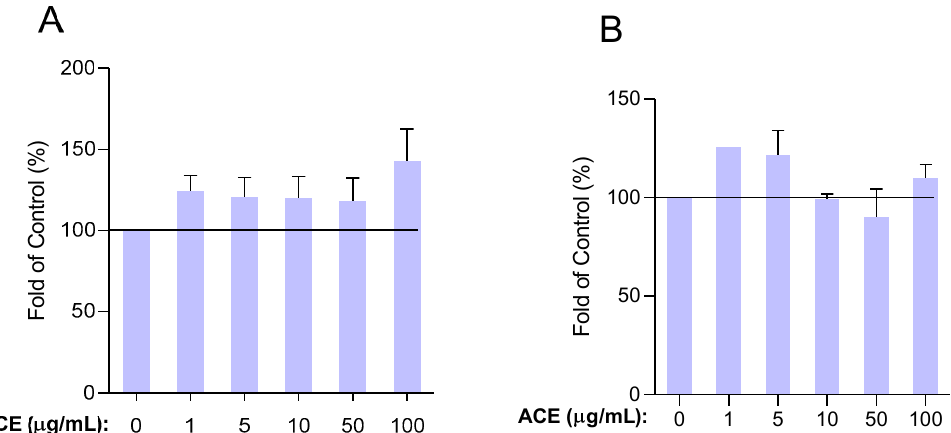
Figure 3. Viability of HUVECs was evaluated at ( A ) 24 h and ( B ) 48 h. Results are expressed in the percentage of the control (100% is represented by the solid lines). Data are expressed as the mean ± SEM of four individual experiments. ACE, anthocyanin extract.